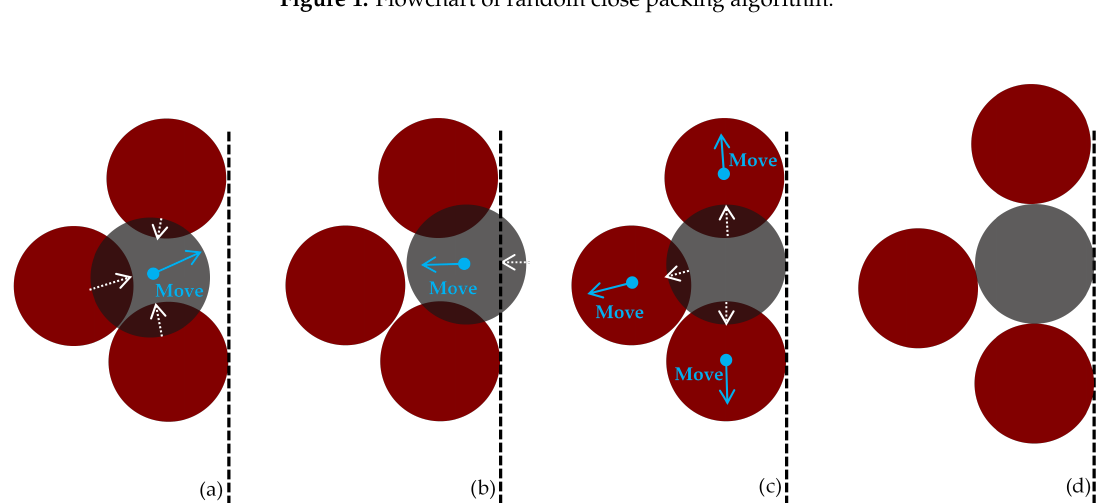
Figure 1. Flowchart of random close packing algorithm.